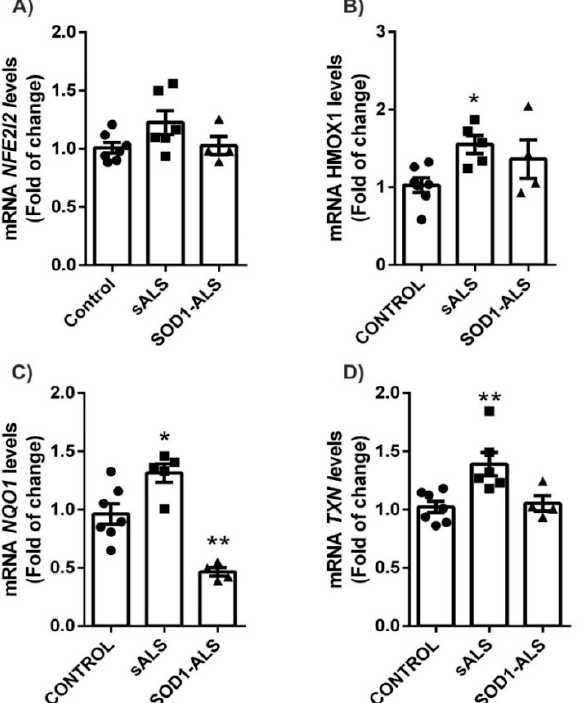
Figure 3. sALS lymphoblasts showed increased mRNA expression levels of NRF2-pathway. Quantitative real-time PCR determination of messenger RNA levels of NFE2L2 ( A ) and NRF2-regulated genes coding HMOX1 ( B ) , NQO1 ( C ), and TXN ( D ), normalized by β -ACTIN messenger RNA levels. Dots indicate the mean of n = 6–7 (controls), n = 5–6 (sALS) and n = 4 ( SOD1 -ALS) samples ± SEM. Asterisks denote significant differences * p < 0.05 and ** p < 0.01, comparing the indicated groups with the basal condition according to a one-way ANOVA followed by Tukey post-test.